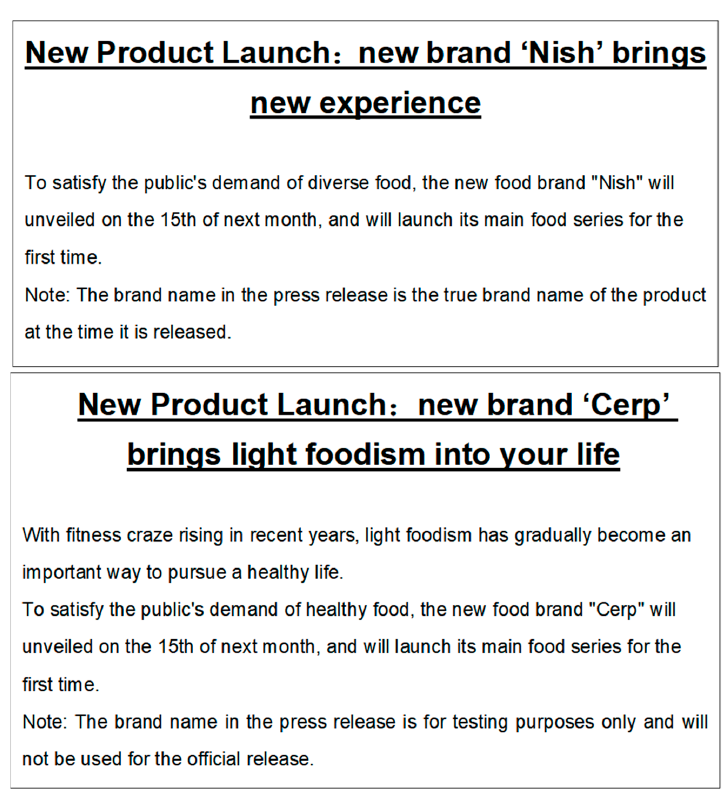
Figure A3. Examples of press releases used in Study 2.